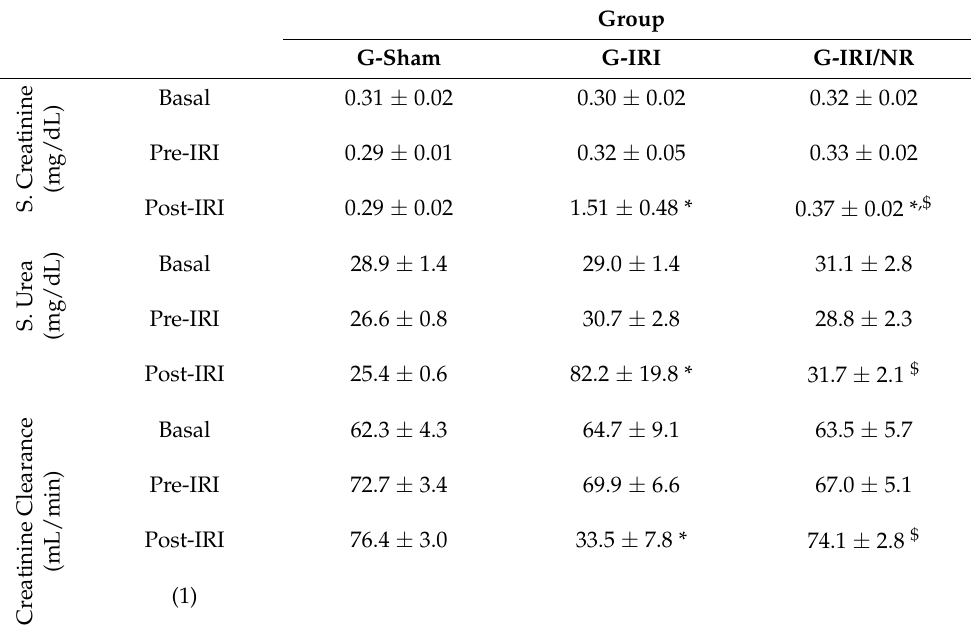
Table 2. Serum creatinine, serum urea and creatinine clearance in all groups before administration of nerolidol/vehicle (basal values), after administration and on the third day following IRI of the nerolidol/vehicle, just before ischemia–reperfusion injury (Pre-IRI) (Post-IRI). * Indicates statistical significance when compared to the Pre-IRI within the same group; $ indicates statistical significance compared to the G-IRI group. Values are expressed as mean ± SEM.